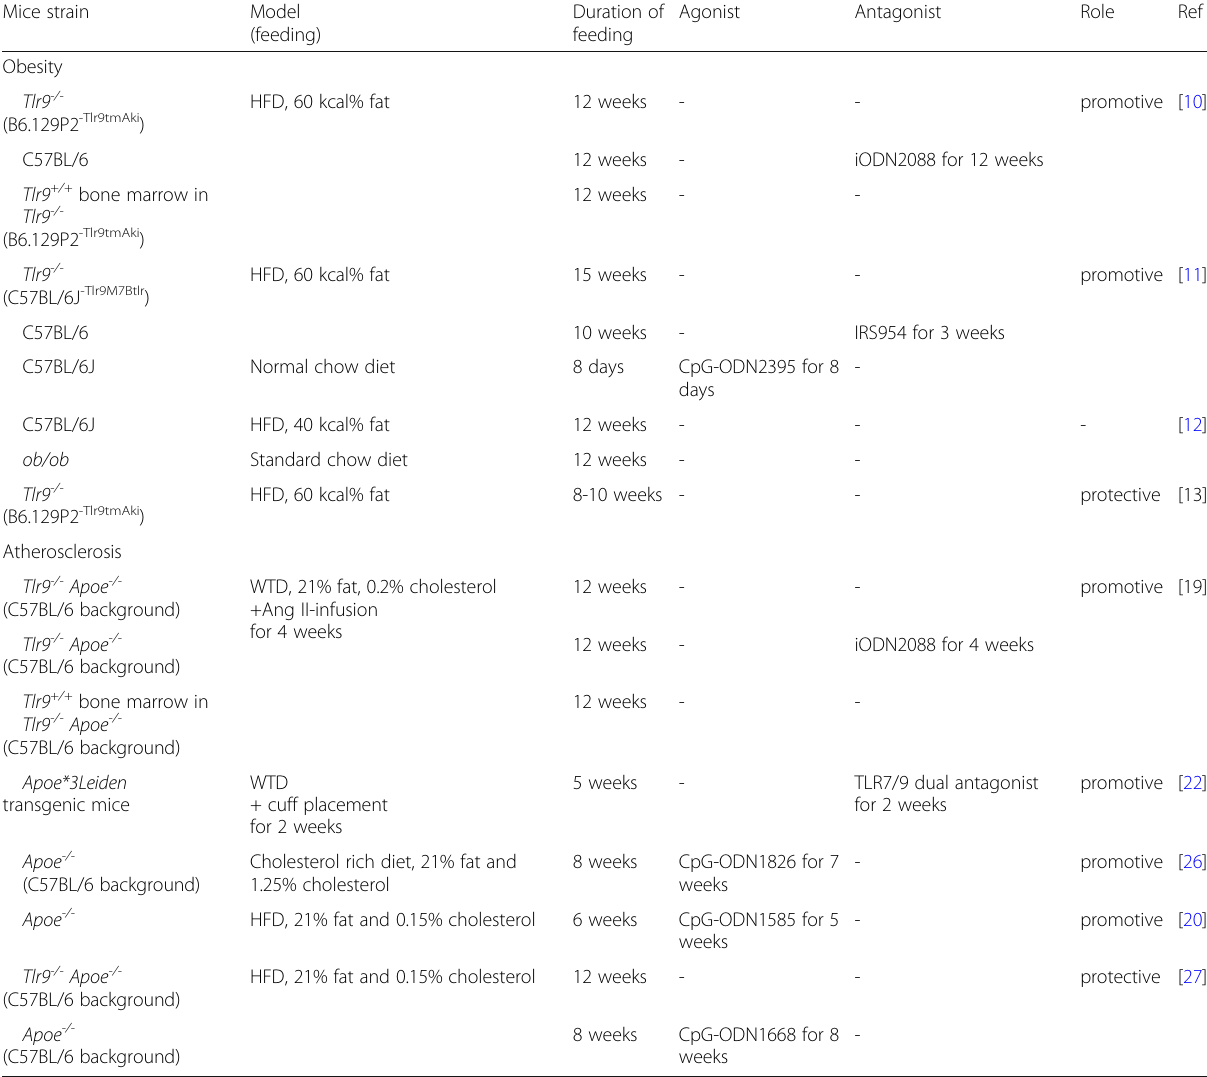
Table 2 Experiment models for exploring the roles of TLR9 in cardiometabolic disorders Mice strain Model